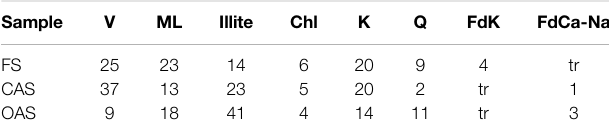
TABLE 6 | Components of the surface free energy (SFE) of soils, for different